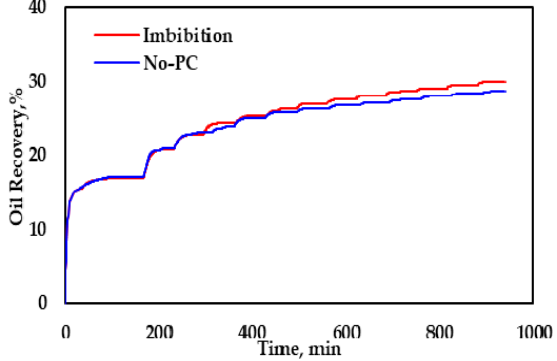
Figure 22. Oil recovery comparison of water huff-‘n-puff with and without imbibition (Case-4).